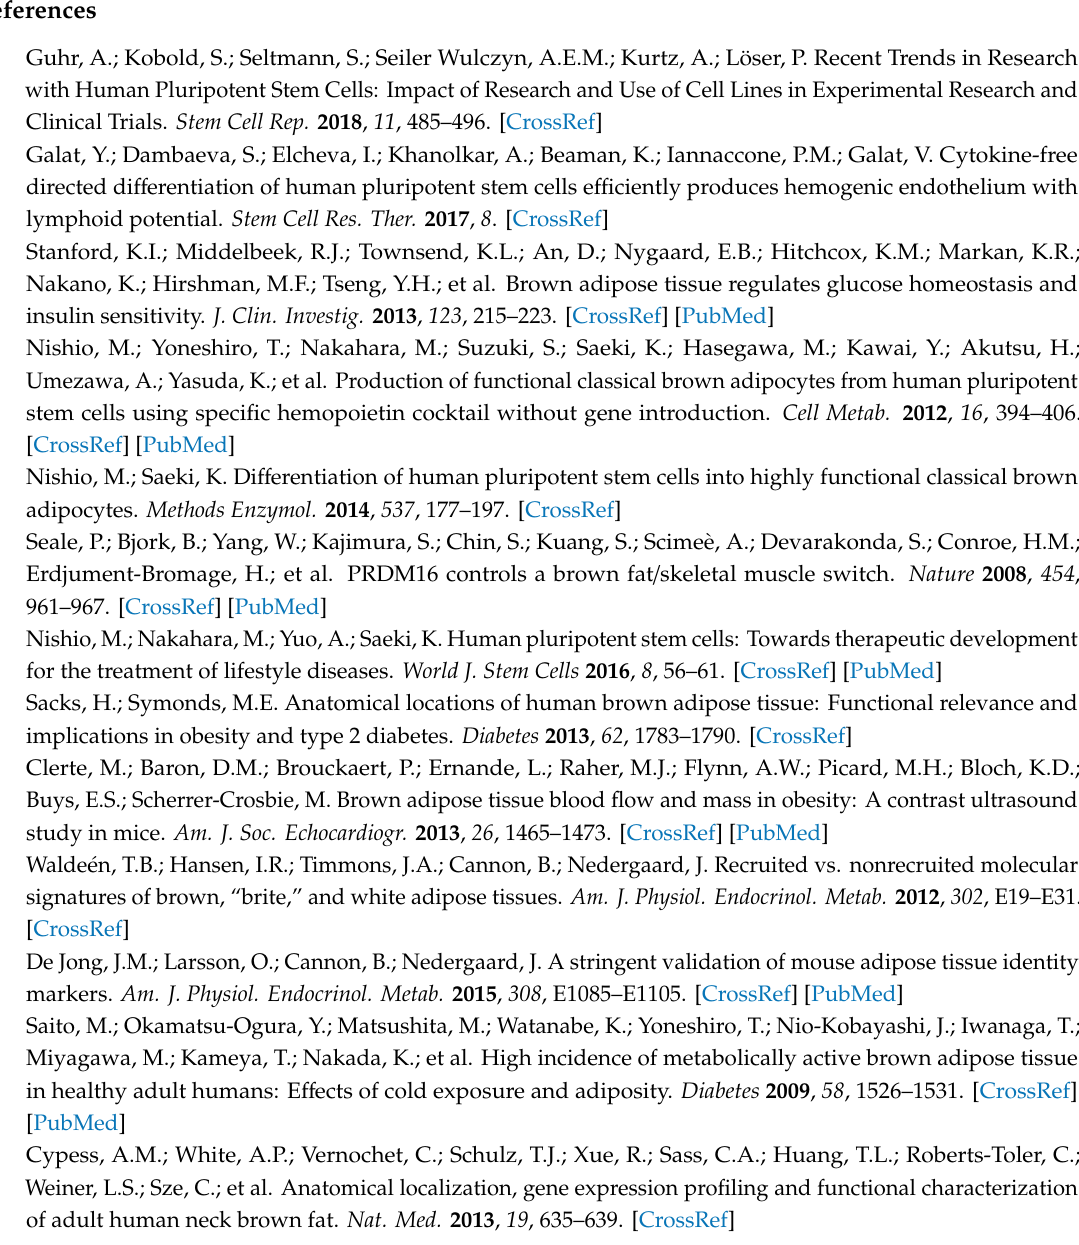
Figure S1: A directed di ff erentiation of feeder-free hESCs into classical BA using 96-well V-shaped